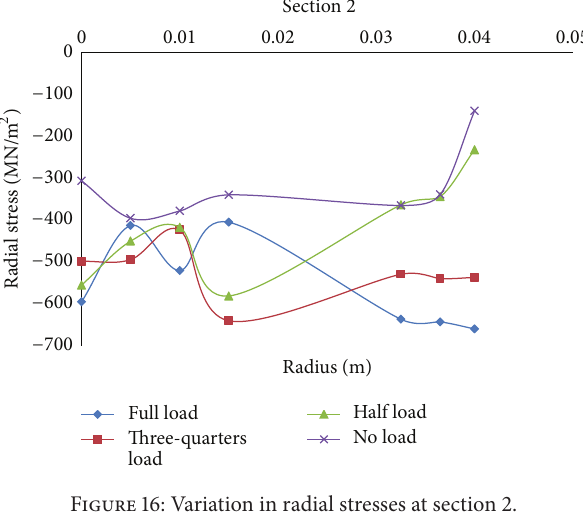
Figure 14: Vertical displacement at section 2.